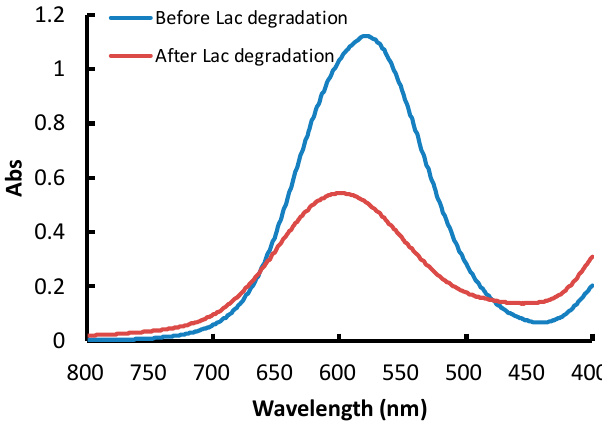
Figure 2. Wavelength scanning of aniline blue solution (50 mg/L) before and after laccase (0.2 U/mL) degradation for 10 min.